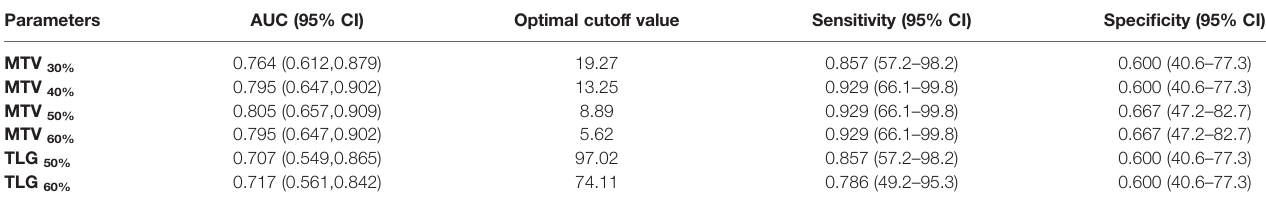
TABLE 4 | Predictive performance of metabolic parameters. Parameters